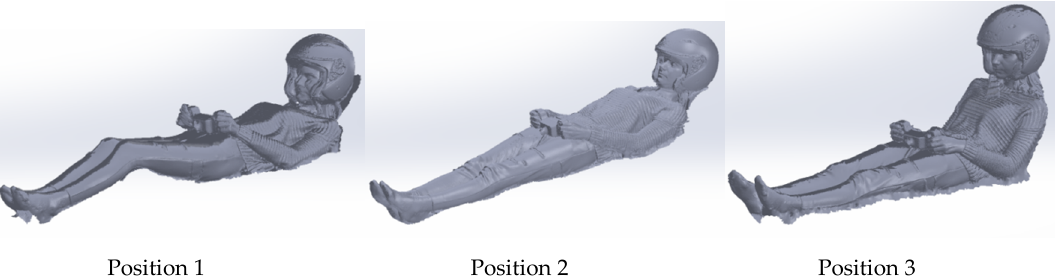
Figure 4. Three scanned positions of the woman pilot.